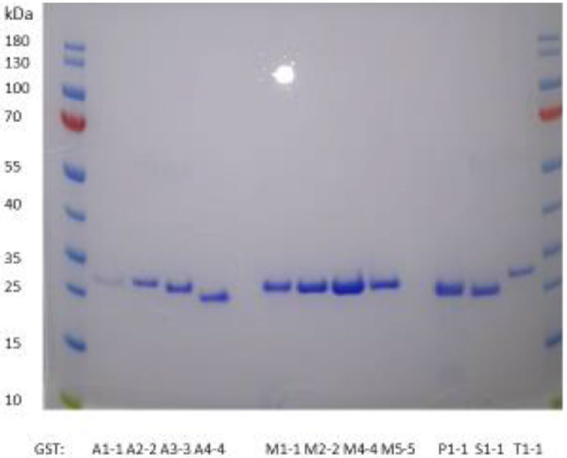
Figure 2. Analysis by SDS-PAGE of purified human GSTs stained with Coomassie Brilliant Blue.